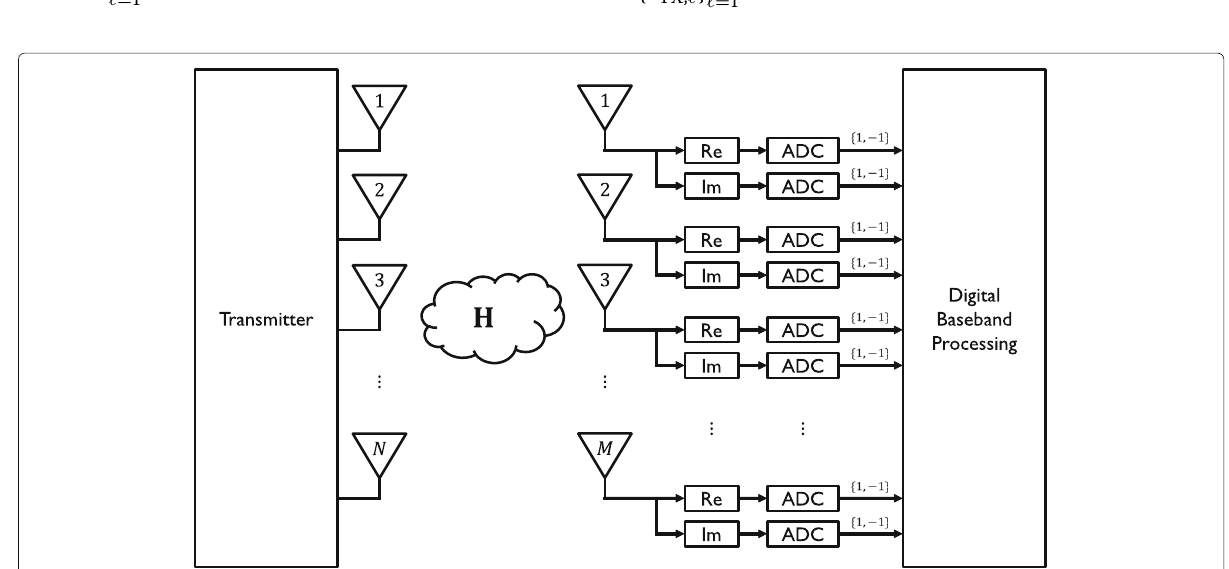
Fig. 1 A mmWave massive MIMO system with an N -antenna transmitter and M -antenna receiver. The real and imaginary parts of the received signal are quantized by 1 bit